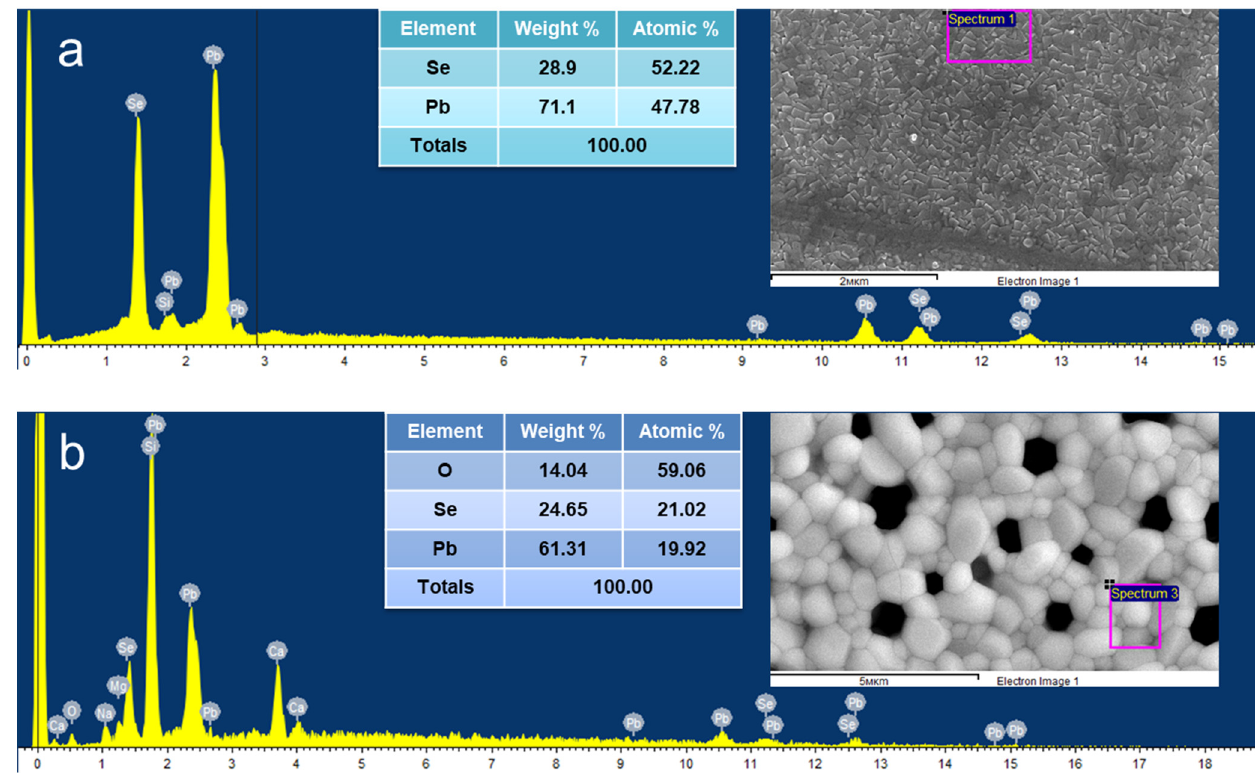
Figure 6. FESEM-EDX image: ( a ) original film, ( b ) film after heat treatment.